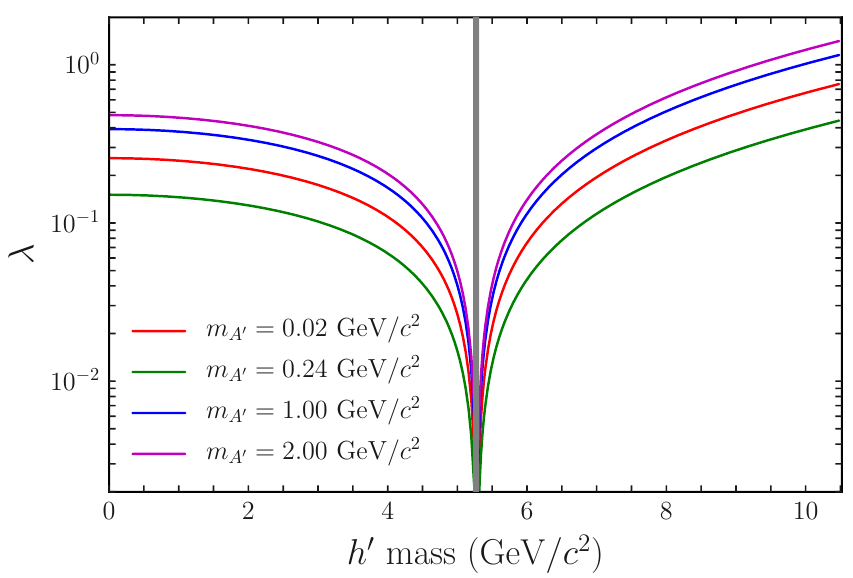
Figure 7 . 90% upper limits of the Higgs portal coupling ( λ ) versus the dark Higgs mass for the 0 . 02 , 0 . 24 , 1 . 00 , 2 . 00 GeV /c 2 dark